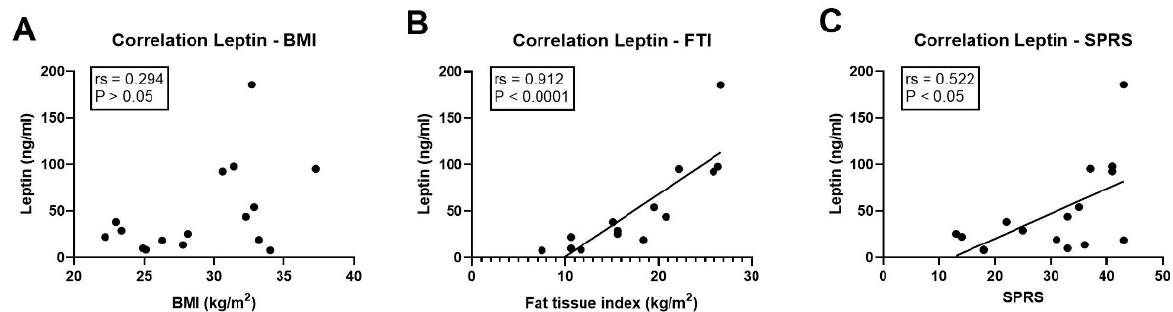
Figure 6. Leptin levels correlate with adipose tissue mass and disease severity in SPG11. ( A – C ) Correlation of leptin levels in SPG11 patients with ( A ) body mass index (BMI; no significant correlation), ( B ) fat tissue index ( p < 0.0001), and ( C ) total score on the Spastic Paraplegia Rating Scale (SPRS; p < 0.05). r s : Spearman’s rho.